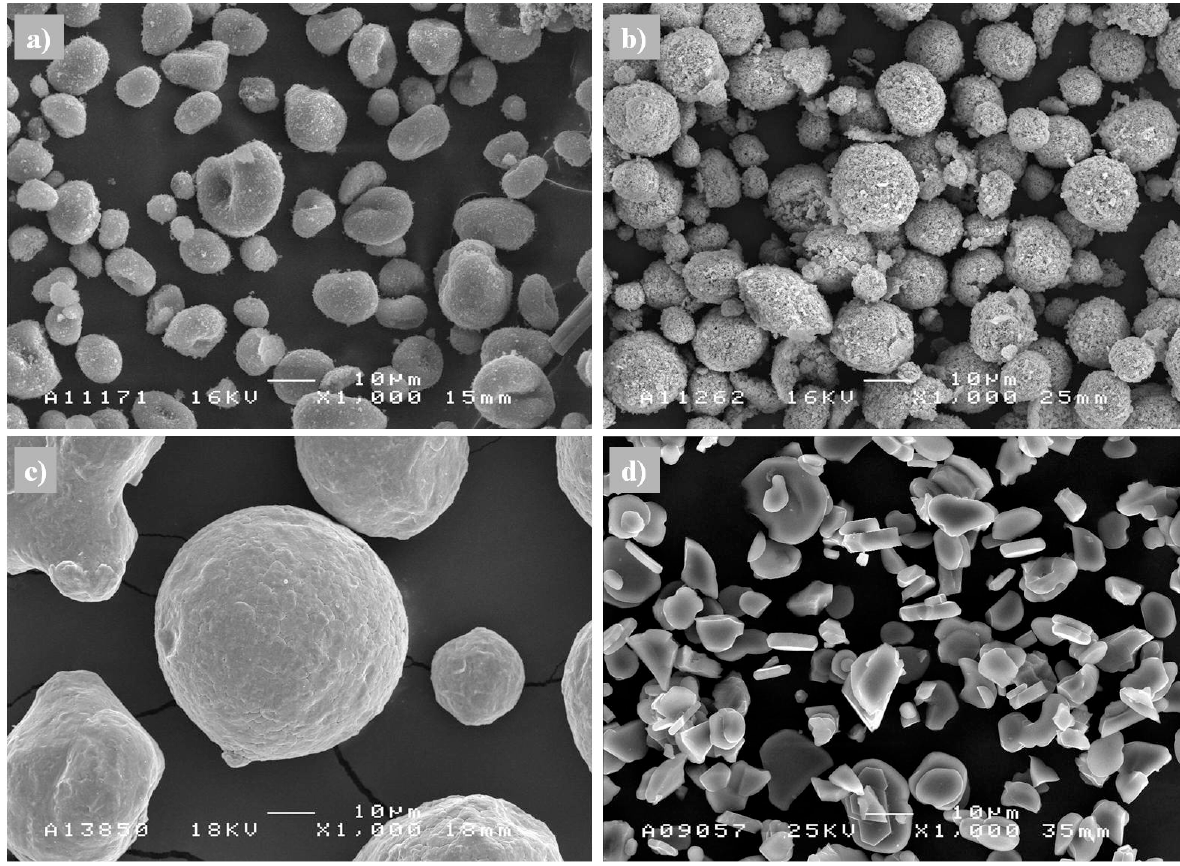
O /SiC; b ) spray dried Cr 2 3 O powder by 2 3